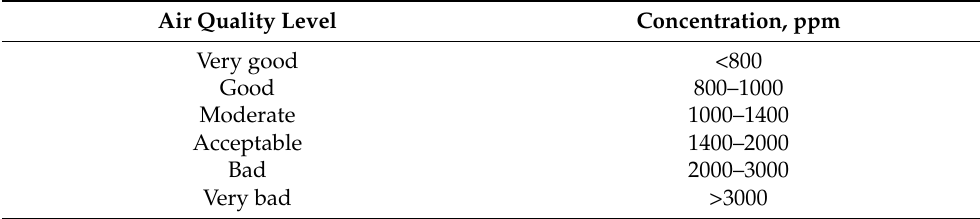
Figure 3. Example of the analyzed hotel room: ( a ) Appearance of the room; ( b ) Location of the measuring device. Table 4. Air quality scale according to carbon dioxide